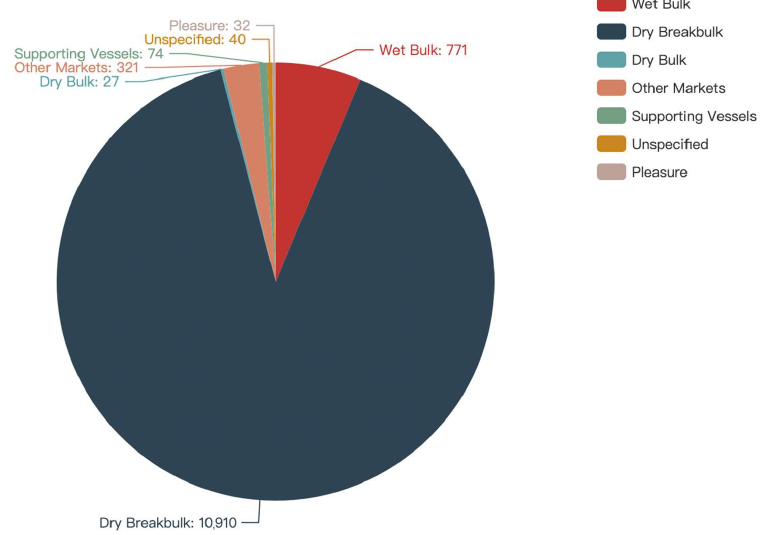
Figure 6. A pie chart of the ship types in Nanjing Port.